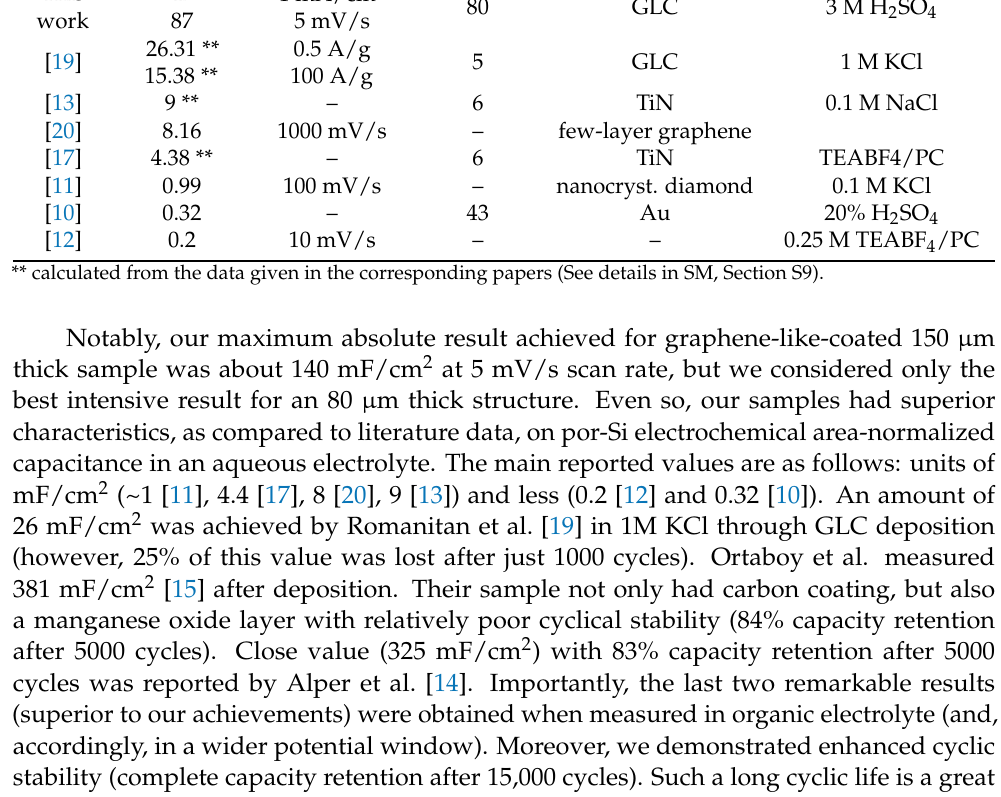
Electrolyte carbon + MnO